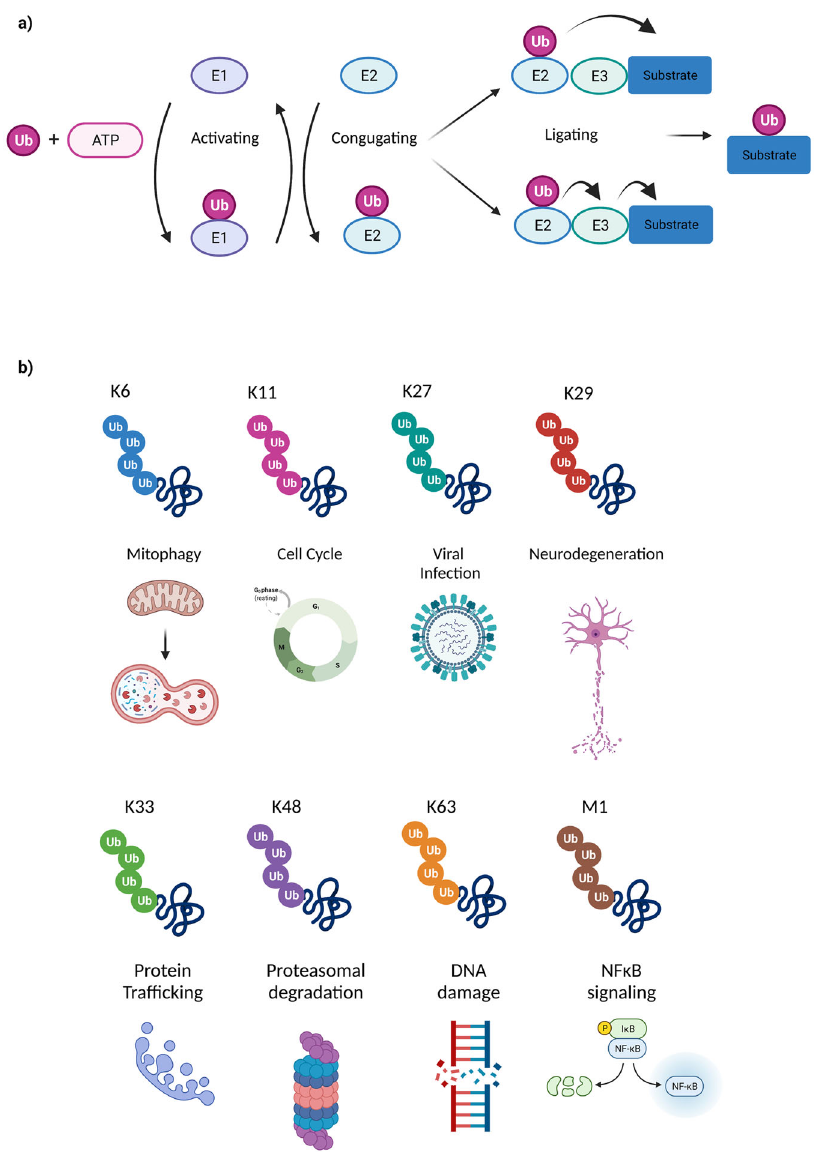
Fig. 1 The ubiquitin code in a snapshot. a Ubiquitylation is an ATP-dependent process that depends on the cooperative action of three sequential enzymes: Ub-activating enzyme (E1), Ub-conjugating enzyme (E2), and Ub E3 ligase (E3). Ub (magenta) is attached covalently to a lysine (K) residue of a substrate protein (dark blue) either through direct transfer from the E2 enzyme to the substrate, or through sequential transfer from the E2 enzyme to the E3 ligase and then to the substrate. b Ubiquitin can form eight different linkage types, using one of seven internal lysine residues (K6, K11, K27, K29, K33, K48, K63) or methionine at position 1 (M1). Speci fi c Ub chains are capable to confer distinct functions of targeted substrates and thereby regulate different cellular processes. The functions illustrated here for each given type of Ub-chain are not restricted to the biological pathway depicted, but are rather representative examples chosen for